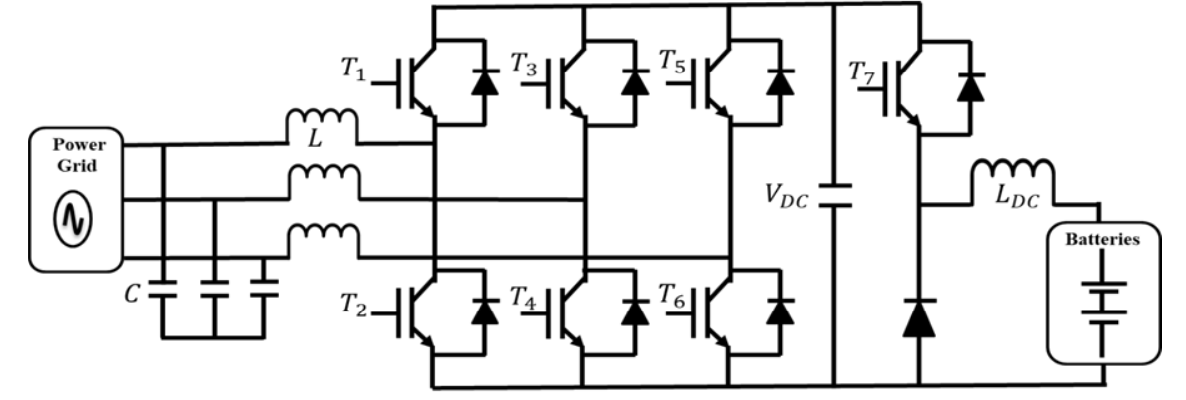
Figure 11. Voltage source-controlled EV fast charger topology.